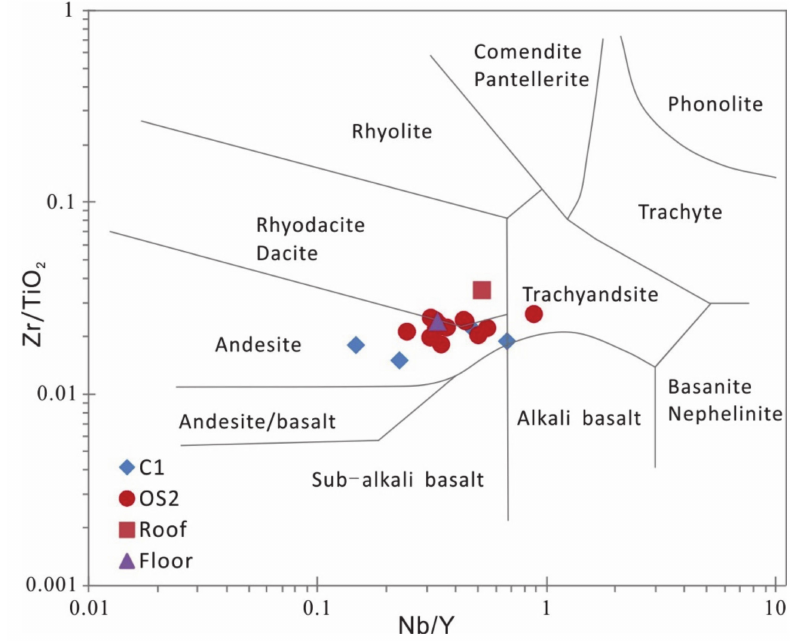
Figure 11. Zr / TiO 2 versus Nb / Y diagrams [41] for C1 coals, OS2 oil shales, and their host rocks as compared with various kinds of volcanic